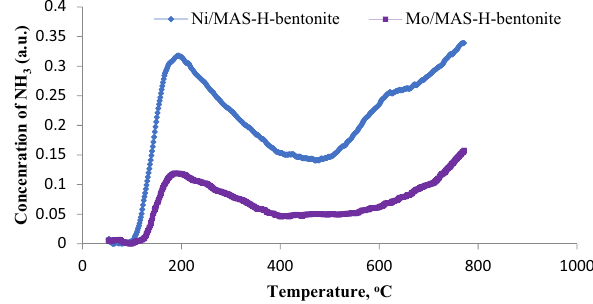
Figure 9: TPD - NH 3 pro fi les of Ni/MAS - H - bentonite and Mo/MAS - H - bentonite catalysts.